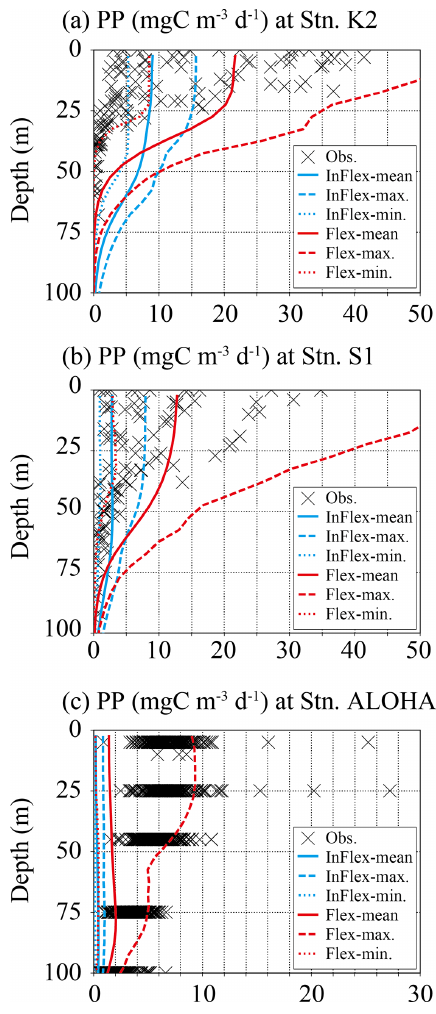
Figure 8. Comparison of vertical primary production (mgCm − 3 d − 1 ) between observed station data and data from the two models at (a) station K2 (47 ◦ N, 160 ◦ E), (b) station S1 (30 ◦ N, 145 ◦ E), and (c) station ALOHA (22.45 ◦ N, 158 ◦ W) in Fig. 1. The observed data (crosses) are from 2010–2019 for station K2, 2010–2013 for station S1, and 2000–2019 for station ALOHA. The mean (solid line), maximum (dashed line), and minimum (dotted line) primary production in 2000–2019 are shown for the two models. Blue lines are for InFlexPFT and red lines are for FlexPFT. The stations are shown as three stars in Fig.